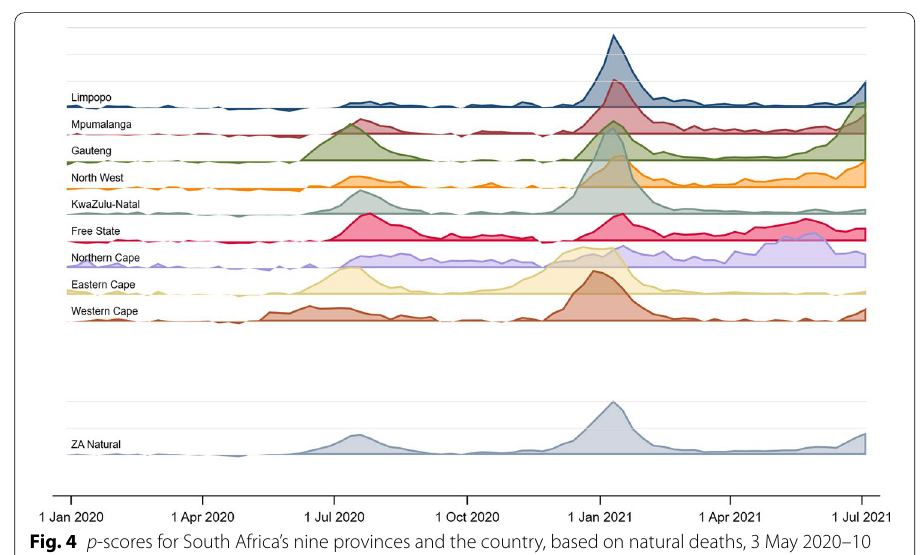
Fig. 4 p -scores for South Africa’s nine provinces and the country, based on natural deaths, 3 May 2020–10 July 2021. Each vertical increment represents 100% extra mortality above the series’